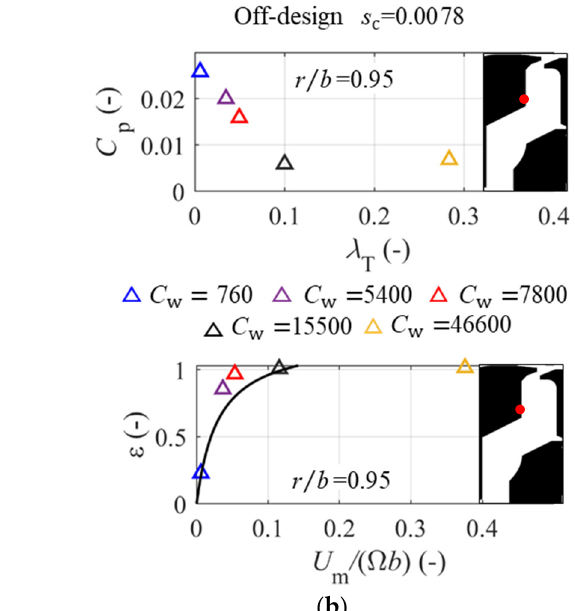
Figure 6. Radial distribution of sealing effectiveness under different conditions of purge supply and annulus flow at Re ∅ = 1.5 × 10 6 for ( a ) s c = 0.0042 and ( b ) s c = 0.0078.